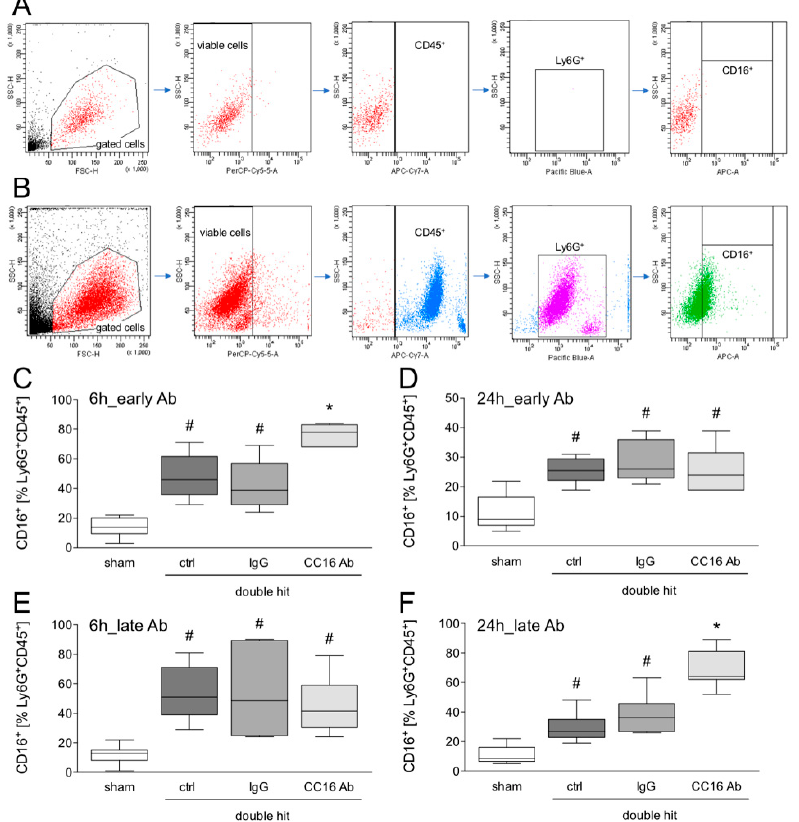
Figure 5. Flow cytometric analysis of CD16 + cells out of viable CD45 + Ly6G + cells in the bronchoalveolar fluid. Gating strategy with isotype control antibodies ( A ) and antibody stainings ( B ) is shown. Interventions with either CC16 antibody (Ab) or IgG control (IgG) antibody were performed, either early (post TxT, C – D ) or late (post-CLP, E – F ) to the lungs. Six or 24 hours later, the animals were euthanized for sampling. *: p < 0.05 versus all; #: p < 0.05 versus sham, n = 8.